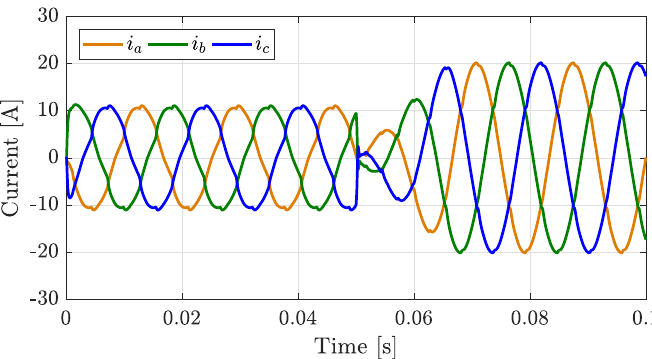
Figure 12. Compensation of PI controller driven by GA under balanced nonlinear conditions.